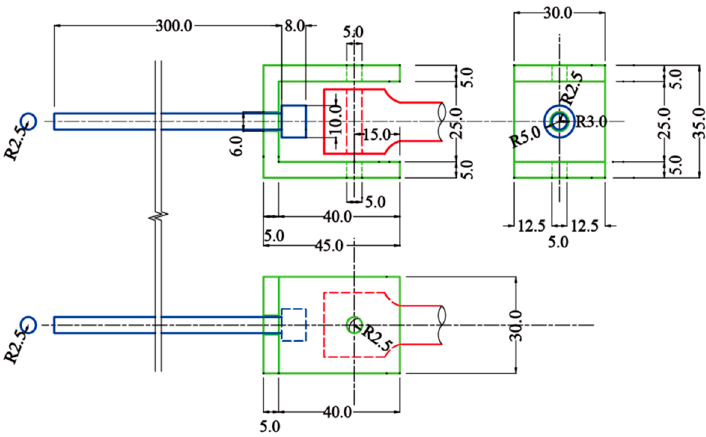
Figure 8. Diagram of tensile test fixture(unit: mm).